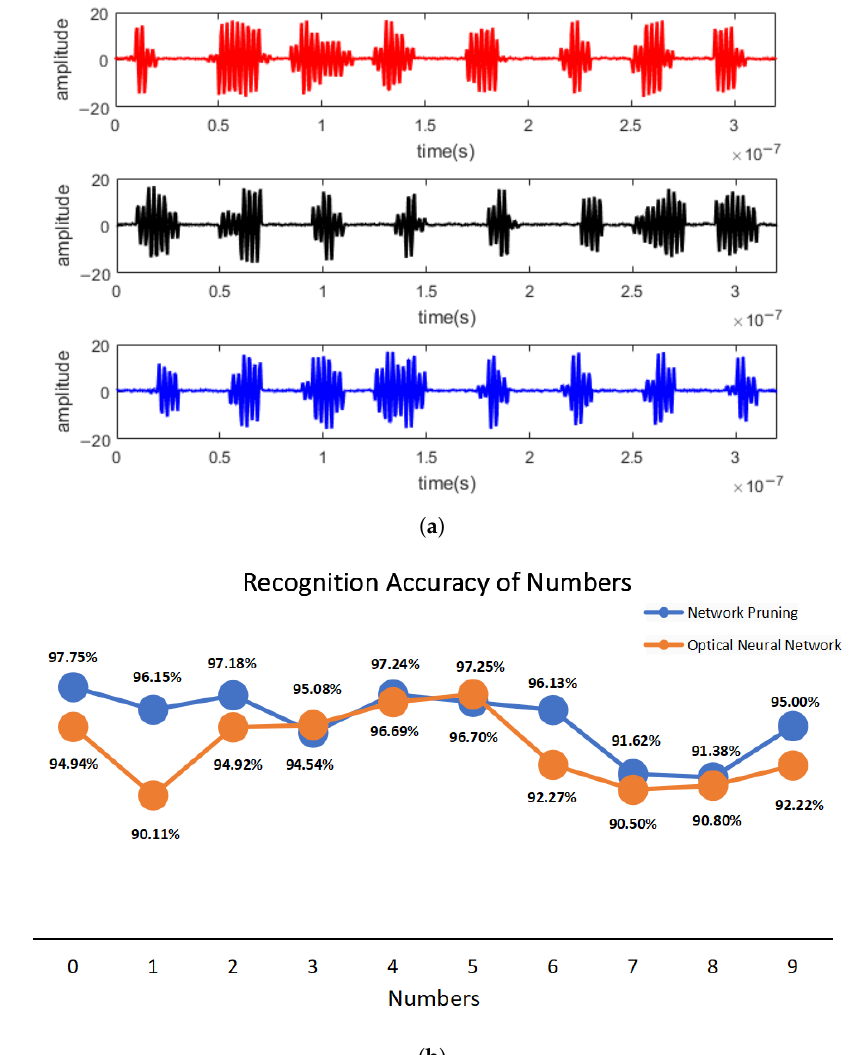
Figure 7. ( a ) The input images are serialized. The red signal is digit 5, the black signal is digit 3 and the blue one is digit 1. ( b ) Results of the MNIST task when pruning 6 layers of MRR banks in an optical backpropagation network with an overall accuracy of